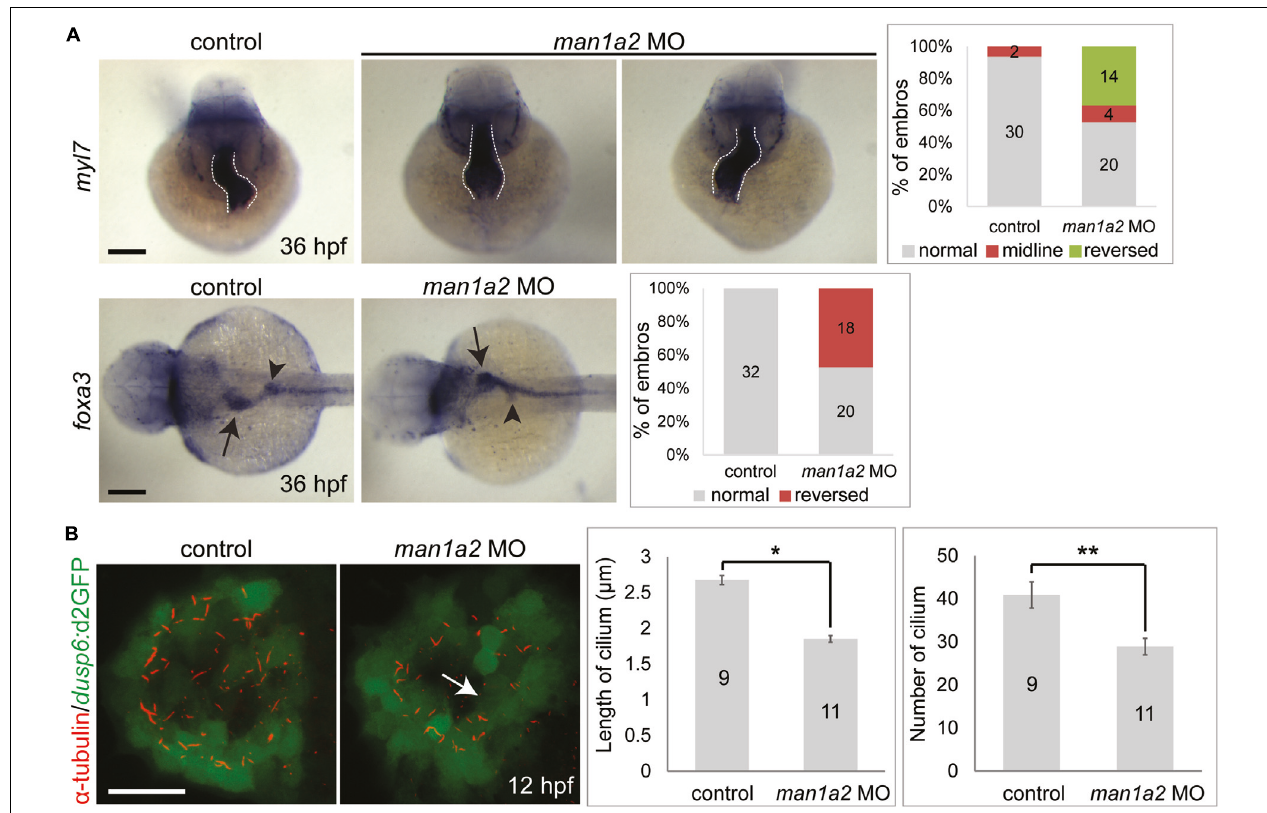
FIGURE 3 | man1a2 knockdown results in laterality defects in zebrafish. (A) Whole-mount in situ hybridization images showing myl7 (cardiomyocytes) and foxa3 (endodermal cells) expression at 36 hpf, which was used to determine the laterality of embryos. Three patterns of heart looping (normal, reversed, and midline) and two patterns of visceral organ position (normal and reversed) were detected and were quantified in graphs. Numbers in the graph indicate the number of larvae in each group. Arrows and arrowheads point to the liver and the dorsal pancreas, respectively; dotted lines outline the heart. Scale bars: 100 µ m. (B) Confocal images of Kupffer’s vesicle showing the expression of dusp6 :d2GFP (green, Kupffer’s vesicle cells) and acetylated tubulin (red, cilia). Both cilia length and number were significantly reduced in man1a2 MO-injected larvae ( n = 11) compared to controls ( n = 9), as shown in graphs. Scale bar: 50 µ m. Error bars: ± SEM. * p < 0.001; ** p <